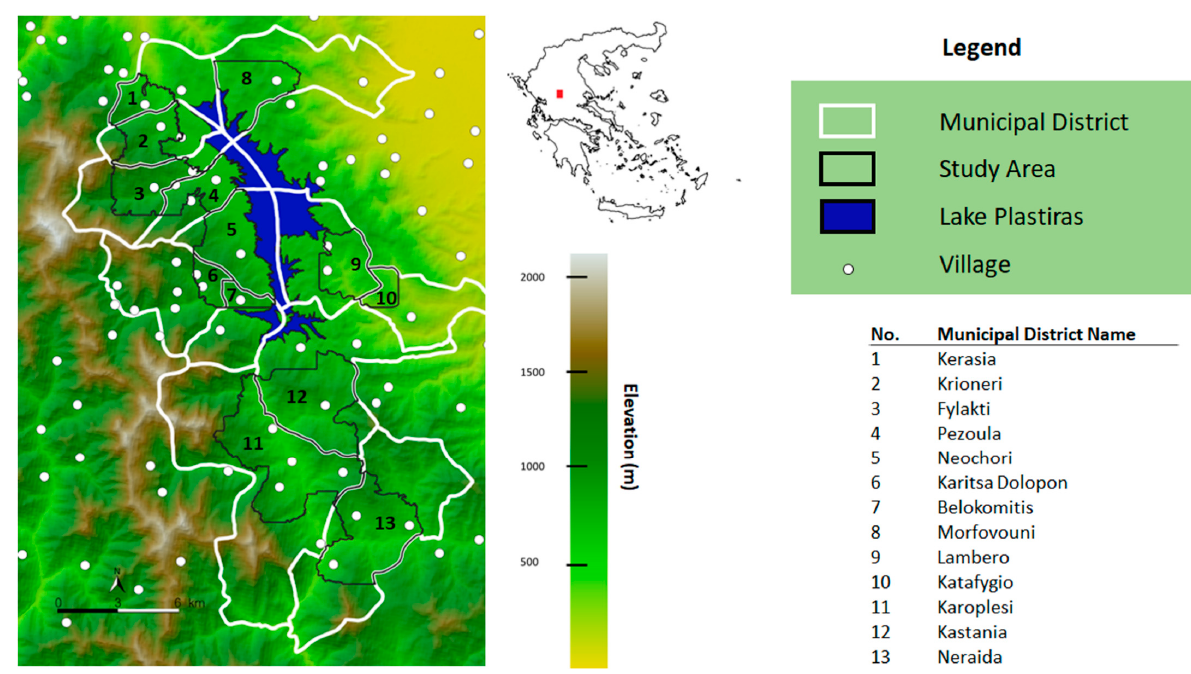
Figure 1. Map of the study area (black line) and the 13 municipal districts overlapping with the study area (white line). Municipal districts are given in the map with numbers, while their names are given in the map’s legend. The geographical location of the study area is indicated by a red box in the inserted map of Greece.